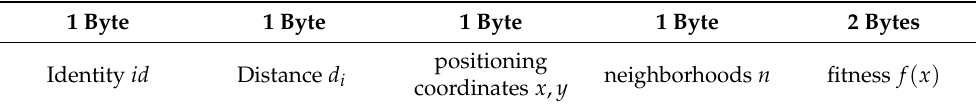
Table 1. Format of the forwarding